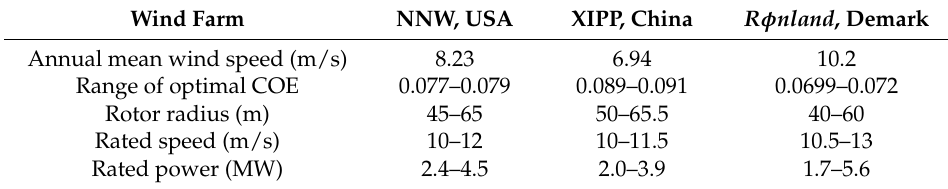
Table 7. The results of the optimum range of COE corresponding the wind